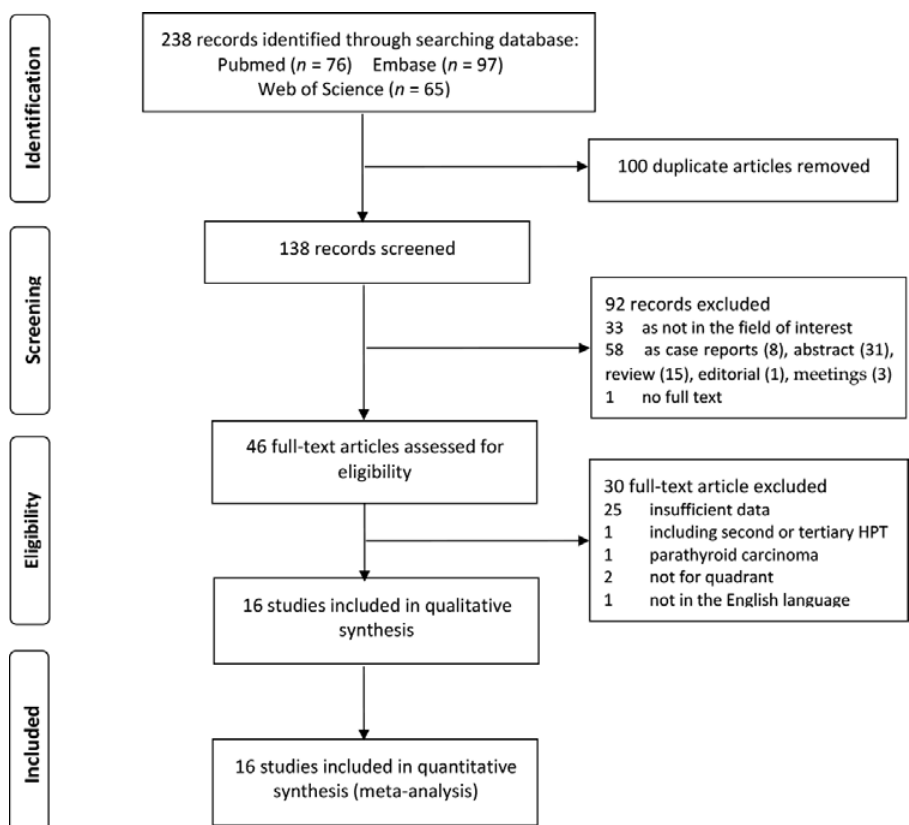
Figure 1. Flow algorithm of selection for eligible studies.